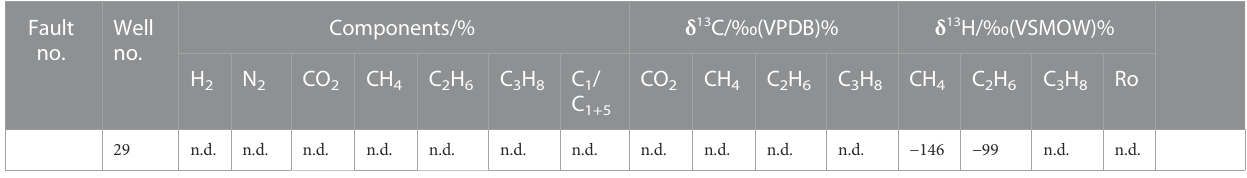
TABLE 1 ( Continued ) Molecular and stable carbon isotopic compositions of natural gases from Shunbei area. Fault Well no. no.